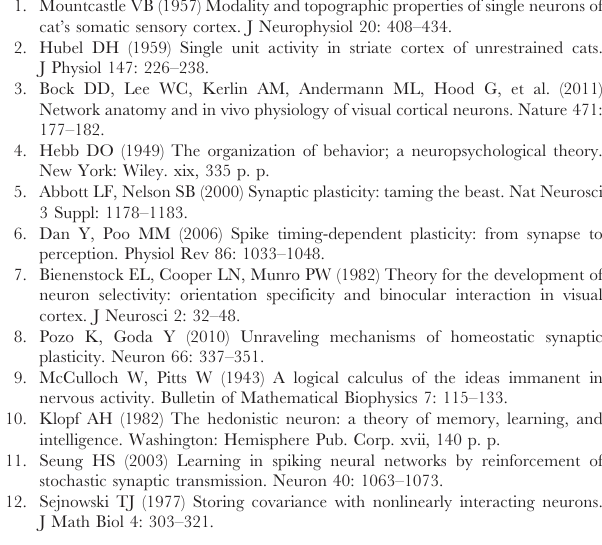
Figure S4 An SSM network for moving bars across a model visual field. Top left: sensory input into a two- dimensional field (20 6 20) generates activities in 400 neurons arranged as shown. Right: synaptic weight matrices (for latencies 1–15). Each of these is a 400 by 400 matrix of synaptic weights (bottom left for latency =1). Positive values correspond to activating synapses, and negative values to inhibitory synapses. SSM parameter choices were as follows: potentiation strength ( a ): 5 6 10 2 5 , spike-rate memory (ms): 50, potentiation memory (mp):